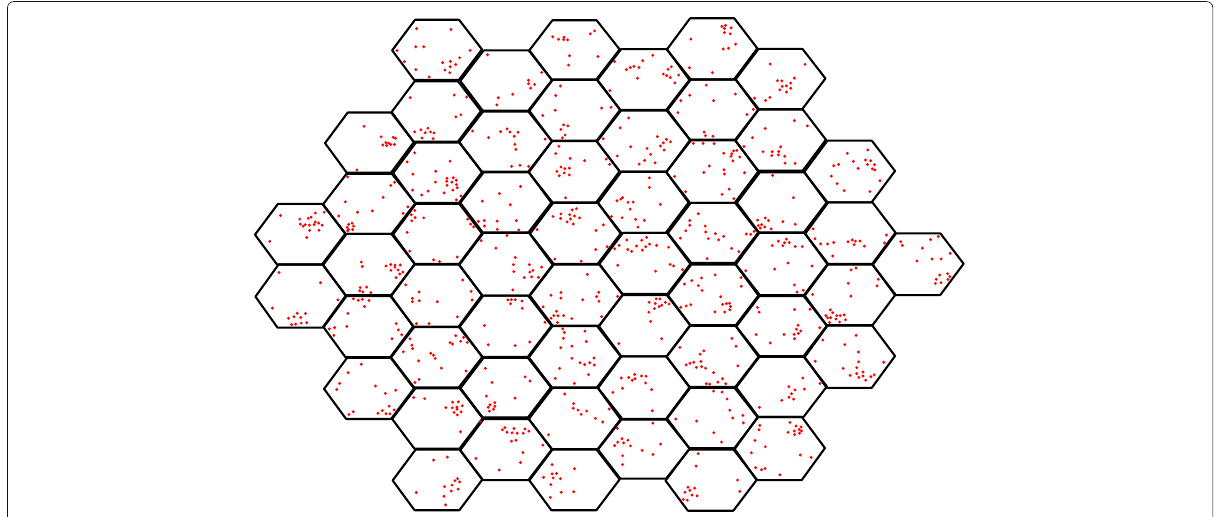
Fig. 4 UEs distribution in the network. This figure represents the UEs repartition in the network for the simulated scenario in Section 3